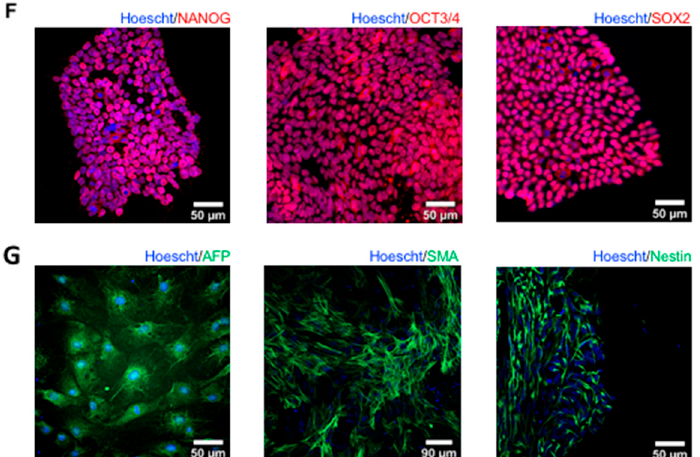
Figure 1. Characterization of the G56R induced pluripotent stem cells (iPSC) line from the NR2E3 - adRP patient. ( A ) Bright-field microscopy of a G56R iPSC colonies. ( B ) Sanger sequencing of exon 2 of NR2E3 showing a G at cDNA position 166 in the DNA of wild type (WT) iPSC and the G>A transition at c.166 in the G56R iPSC line. ( C ) RT-PCR detection of the reprogramming vectors in RNA from non-transduced patient fibroblasts (Fibro; negative control), fibroblasts transduced with the Sendai virus vectors (Fibro + SeV; positive control) and G56R iPSCs using primers specific for either the vector backbone (SeV) or for each reprogramming cassette: polycistronic KLF4 , OCT3/4, and SOX2 (KOS), or monocistronic KLF4 and MYC . Primers for the housekeeping gene GAPDH were used as a positive control for the PCR reaction. ( D ) Karyotype analysis of the G56R iPSC line showing normal chromosomal number and structure. ( E ) qPCR analysis of the expression of the host pluripotency genes NANOG (left), OCT3/4 (middle), and LIN28A (right) in cDNA from non-transduced patient fibroblasts (Fibro; negative control), fibroblasts transduced with the Sendai virus vectors (Fibro + SeV) and G56R iPSCs. The results are expressed as mean ± SEM ( n = 3). ( F ) Immunofluorescence (IF) studies of the expression of endogenous NANOG (left), OCT3/4 (middle) and SOX2 (right) in G56R iPSCs; nuclei labelled in blue. ( G ) IF studies following embryoid body differentiation of G56R iPSCs for the expression of the germ layer markers Alpha Fetal Protein (AFP) (endoderm; left), Smooth Muscle Actin (SMA) (mesoderm; middle), and Nestin (ectoderm; right).